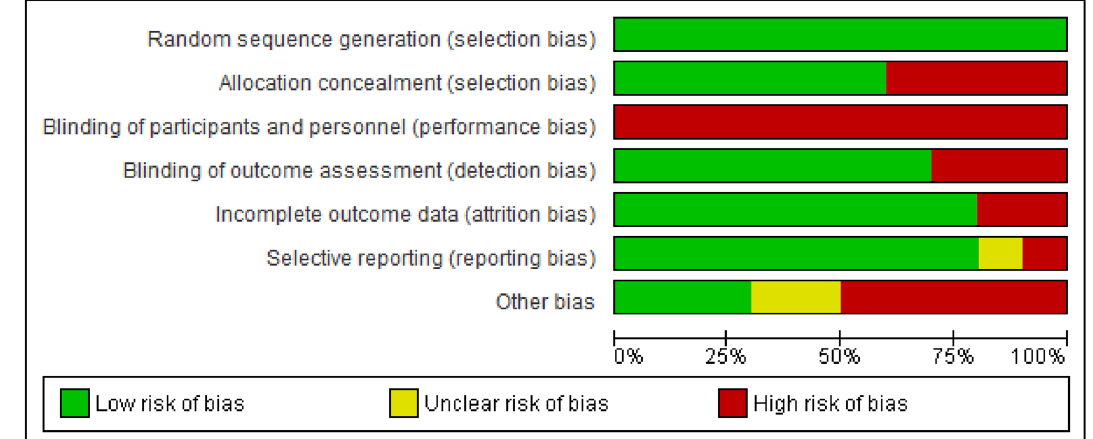
Figure 3. Risk of bias graph: review authors’ judgments about each risk of bias item presented as percentages across all included studies. Revman 5. https:// train ing. cochr ane. org/ online- learn ing/ core- softw are- cochr ane- revie ws/